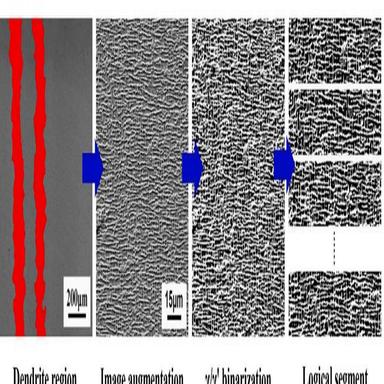
Dendrite segment and global γ/γ' two-phase microstructural parameters quantitation.